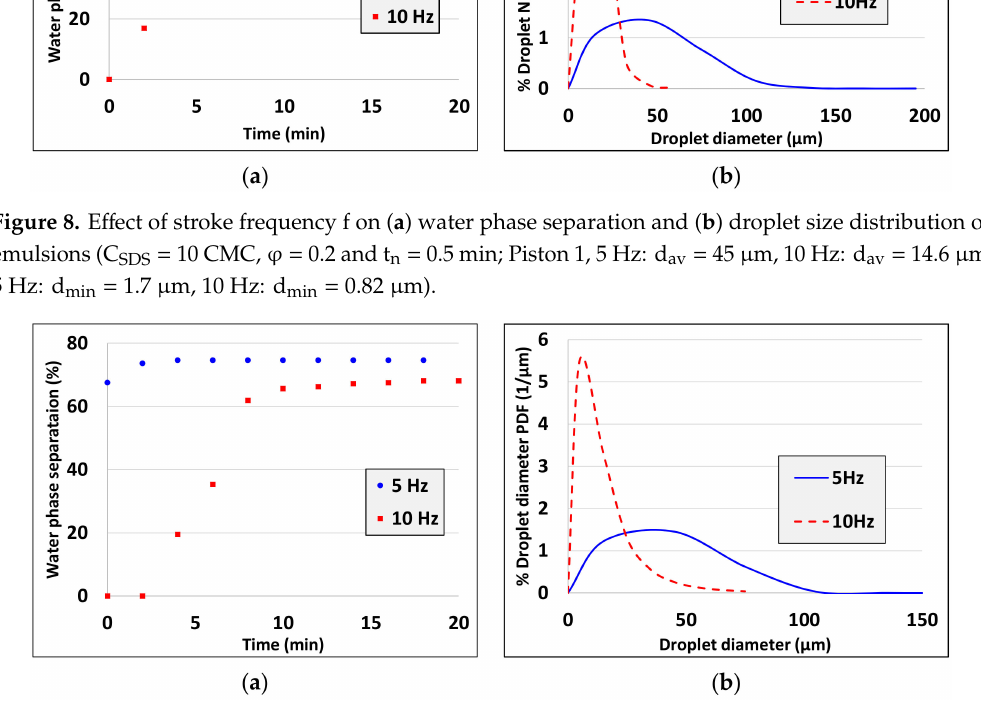
Figure 9. E ff ect of stroke frequency f on ( a ) water phase separation and ( b ) droplet size distribution of emulsions (C SDS = 10 CMC, ϕ = 0.2 and t n = 2 min; Piston 1, 5 Hz: d av = 39.4 µ m, 10 Hz: d av = 10.9 µ m, 5 Hz: d min = 1.7 µ m, 10 Hz: d min = 0.82 µ